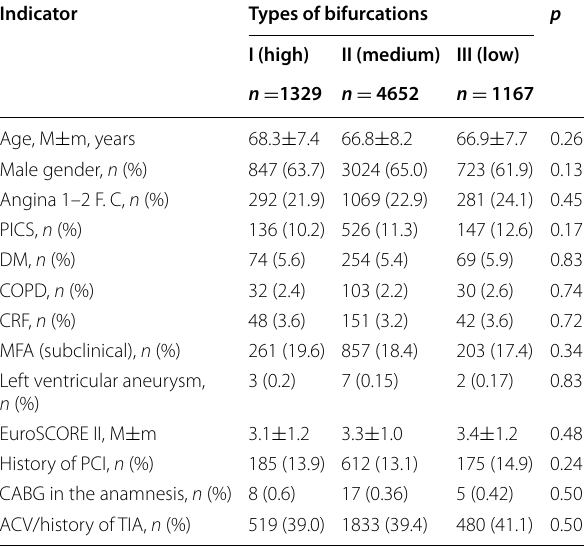
Table 1 Comparative clinical and anamnestic characteristics of patient groups